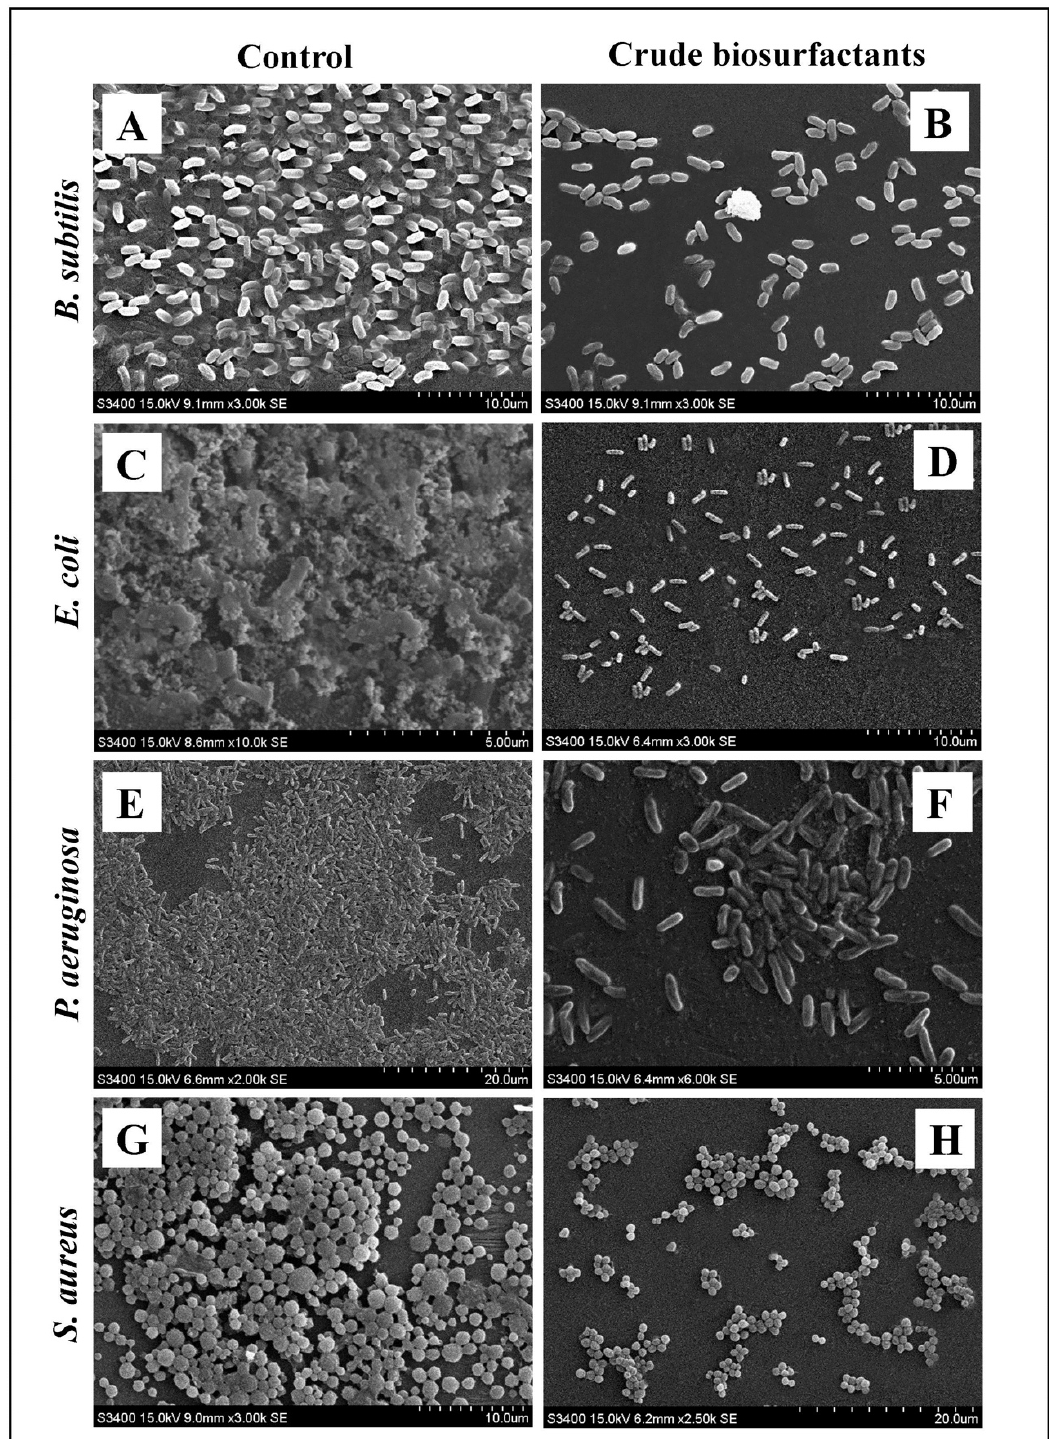
Figure 7. Micrographs of the disrupted matured biofilms of the test pathogens by the L. rhamnosus crude biosurfactant formed on a glass surface at their respective MICs under SEM. Growth control ( A , C , E , G ); with the L. rhamnosus crude biosurfactant ( B , D , F , H ).